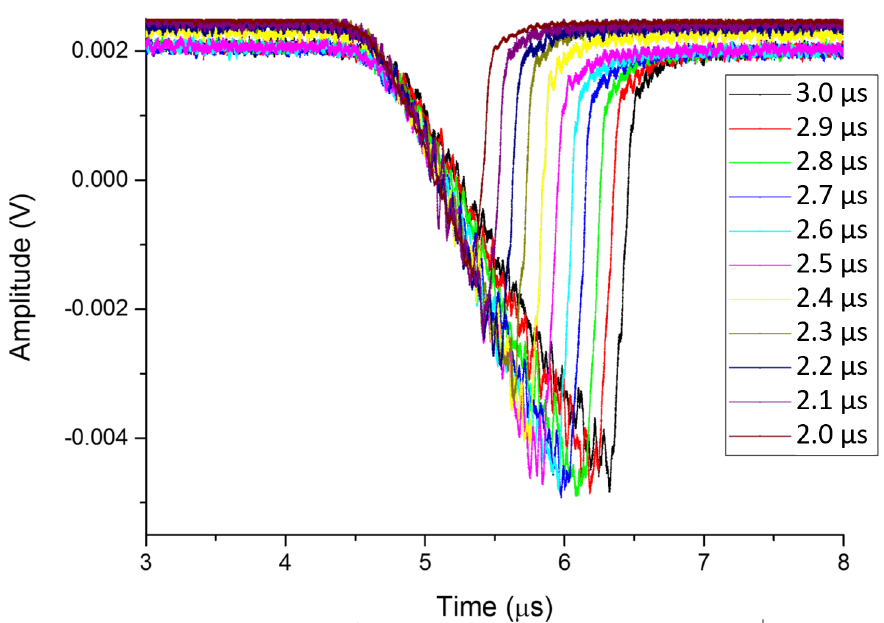
Figure 12. The Cherenkov signal for one fibre as a function of time during a 10 MW input RF pulse with the width varied from 2 µ s to 3 µ